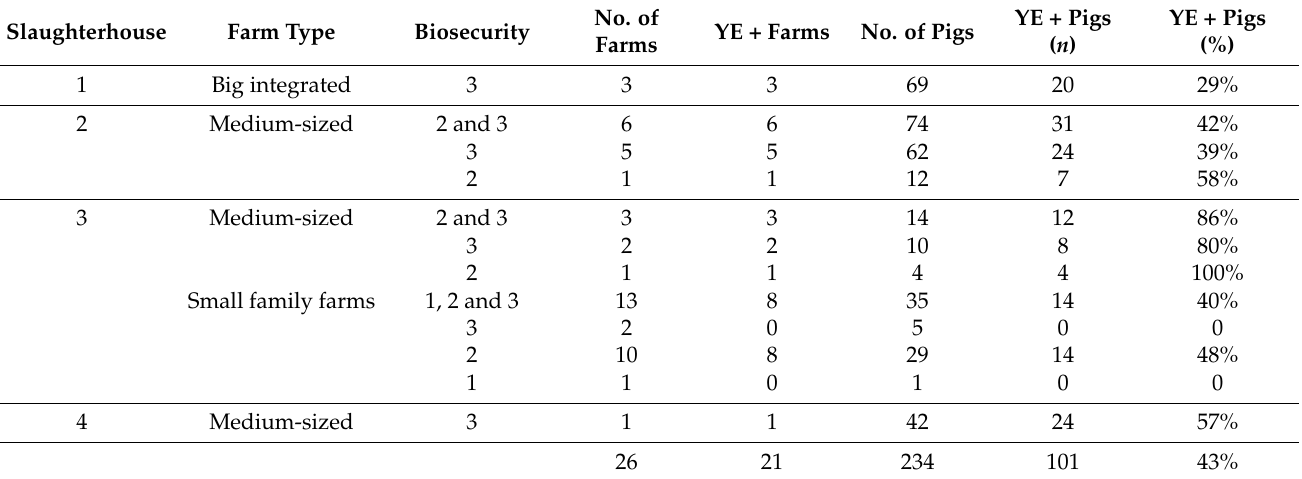
Table 2. Prevalence of Y. enterocolitica in tonsils of pigs from different housing systems and